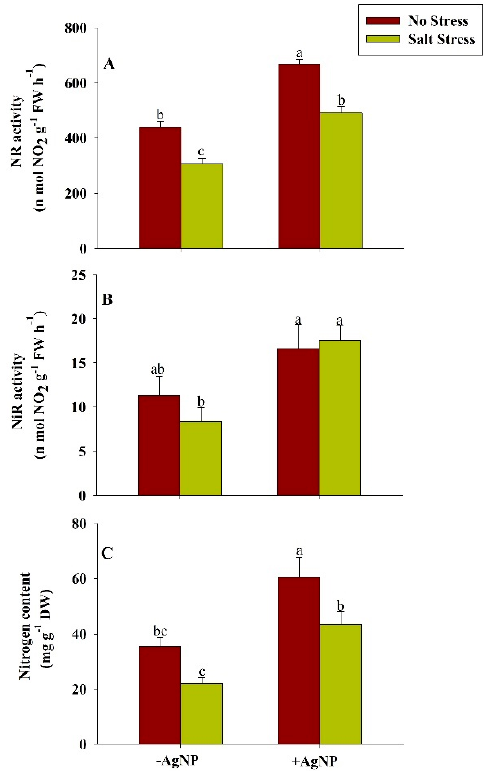
Figure 5. Estimation of nitrogen assimilation: ( A ) nitrate reductase activity (NR), ( B ) nitrite reductase activity (NiR) and ( C ) nitrogen content in wheat at 30 DAS. Plants were grown individually with 0 (control), 100 mM NaCl, 300 ppm AgNPs and NaCl combined with AgNPs. Data are presented as treatments mean ± SE (n = 3). Data followed by the same letter are not significantly different by LSD test at ( p ˂ 0.05).